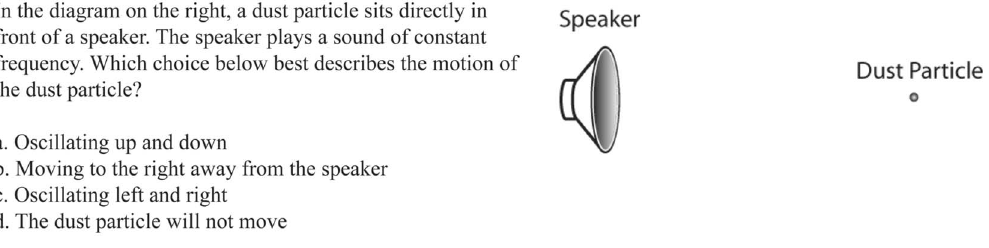
FIG. 10. Question 3 from the sound waves quiz, identical for all three experimental groups.